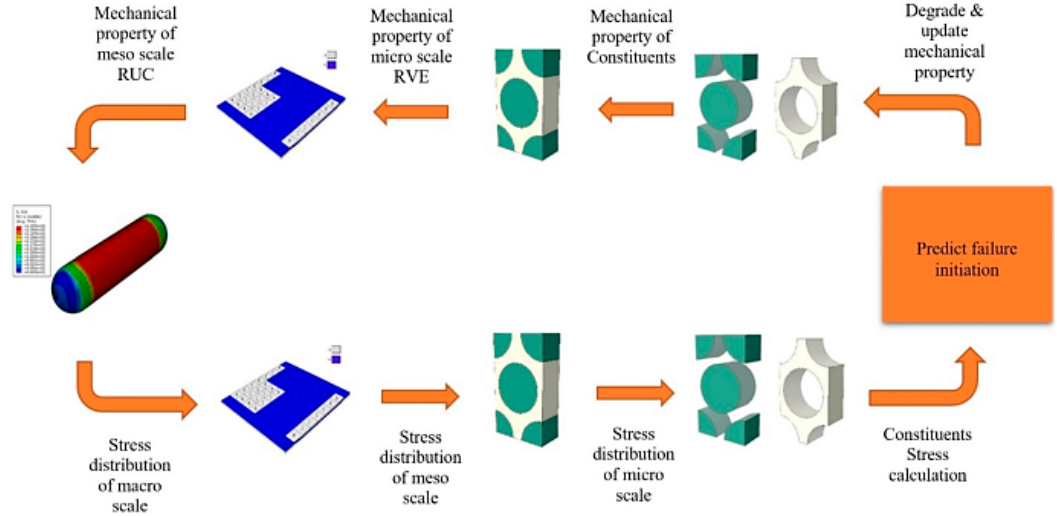
Figure 21. Multi-scale modeling to predict the burst pressure in filament wound composite pressure vessels [94].